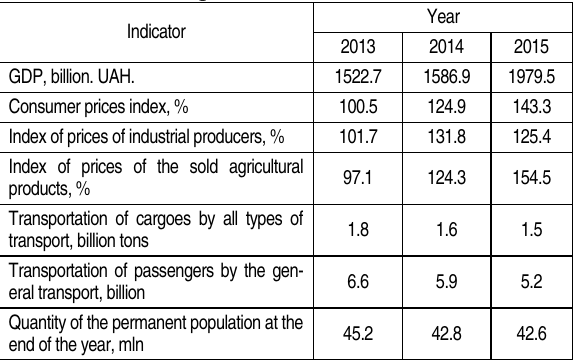
Table 2. The main economic characteristics of devel- opment in Ukraine